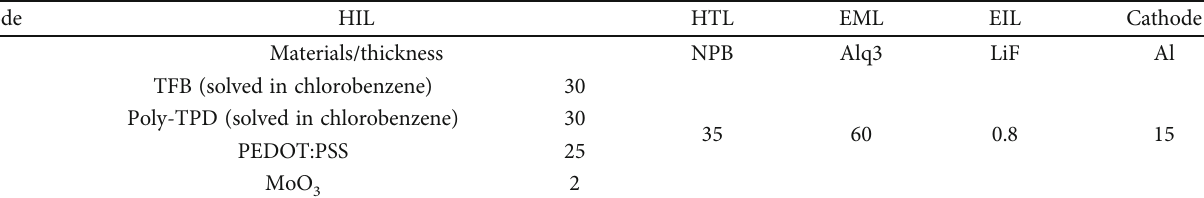
Table 2: Device parameters with di ff erent hole injection materials (unit: